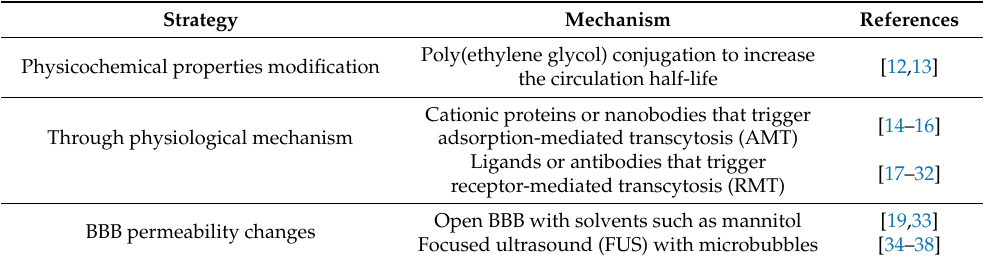
Table 1. Summary of different strategies to cross the BBB with proteins or antibodies. Strategy